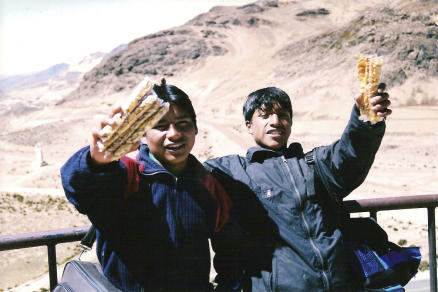

Haberos: Snack Sellers in Ticlio(Photo: Javier Villafuerte-Galvez)